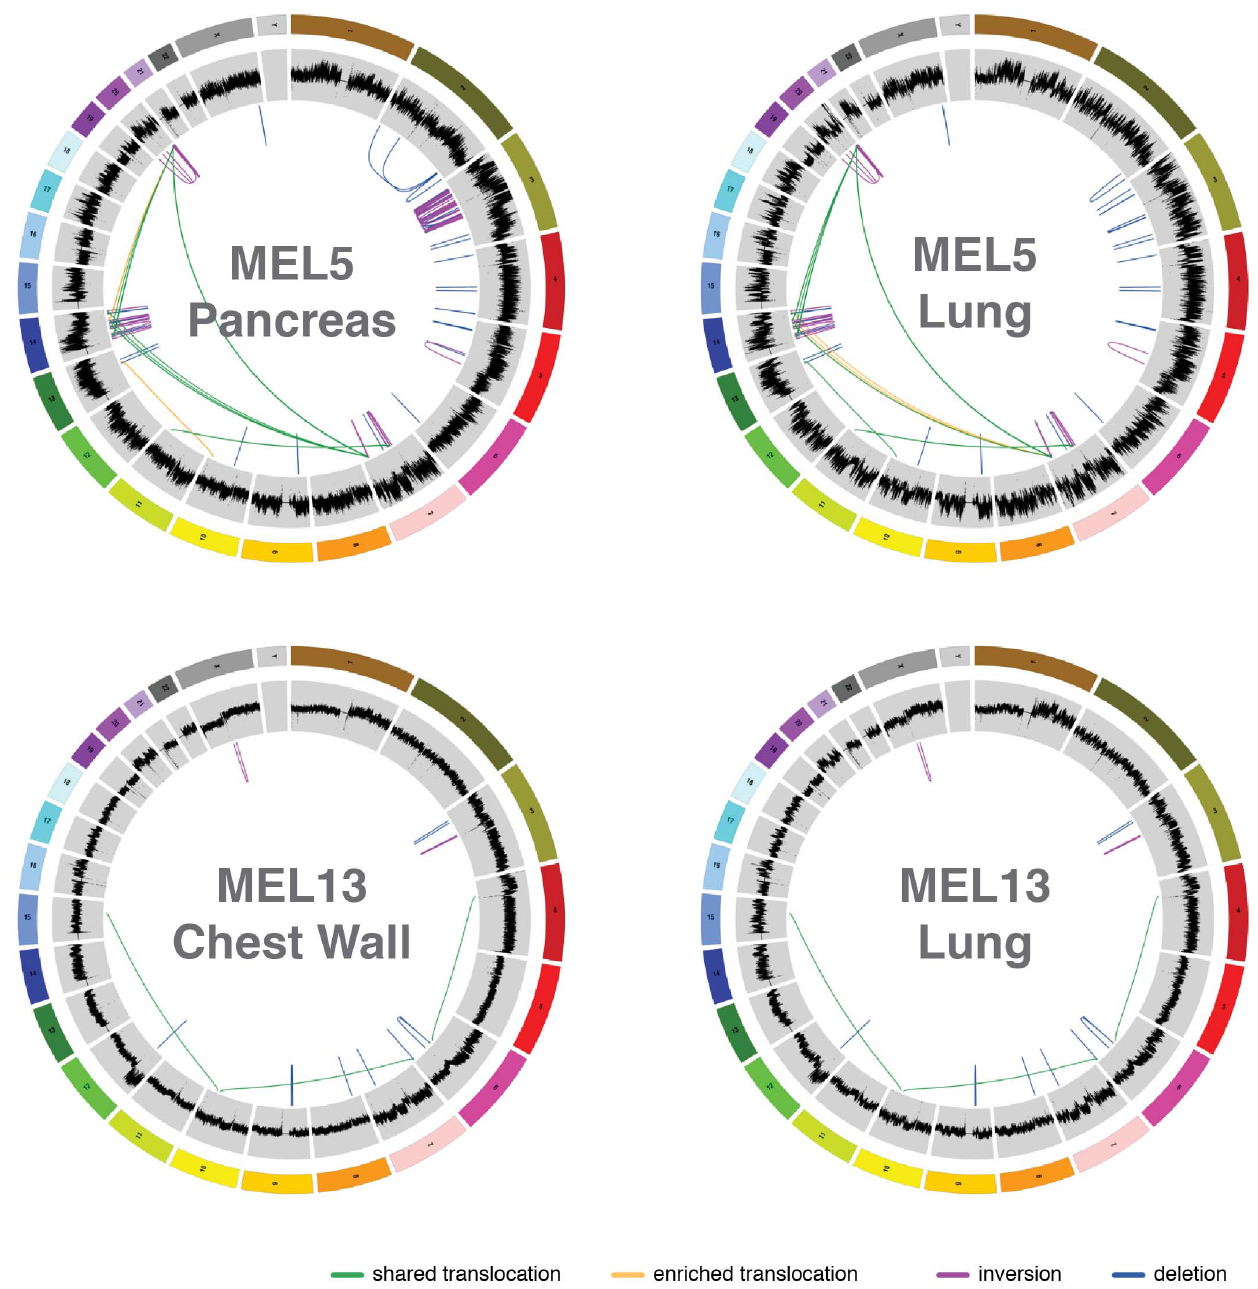
Figure 5. Comparison of Circos plots of the metastatic samples from two tissue sites of the same individuals (MEL5 and MEL13). In MEL5, pancreas tumor specific structural variants (inversions and deletions) are clustered on chromosomes 2 and 5, and pancreas or lung enriched rearrangements are drawn in yellow. In MEL13, highly similar copy number and structural variant patterns between lung and chest wall metastases are shown. No purity-based copy number corrections were used for plotting copy number.